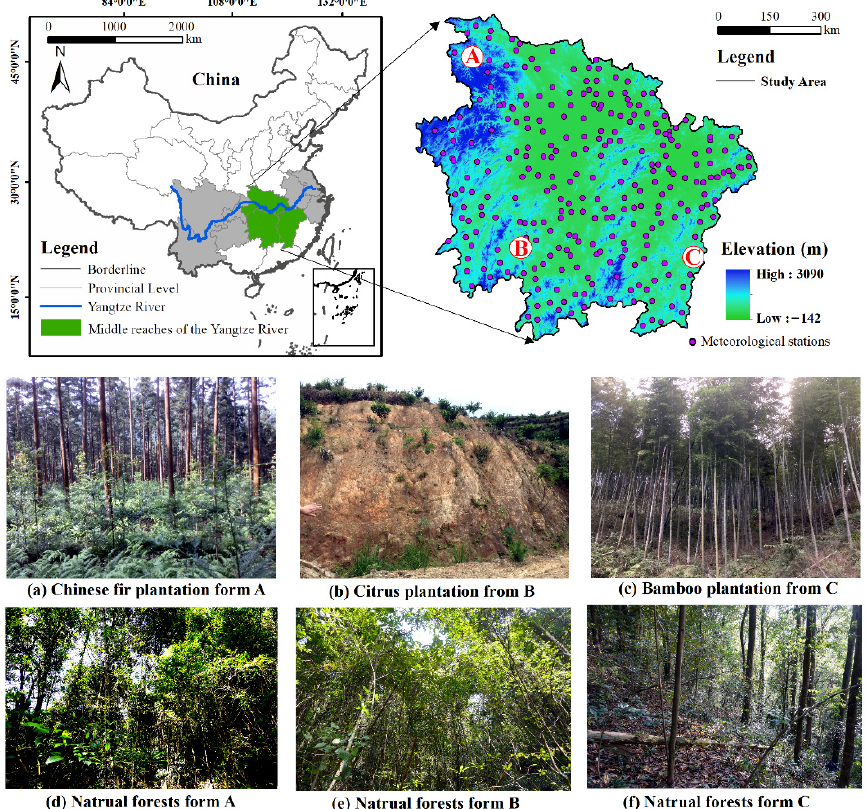
Figure 1. The location of MRYR in China. ( a – c ) plantations in the study areas; ( d – f ) natural forests in the study areas.